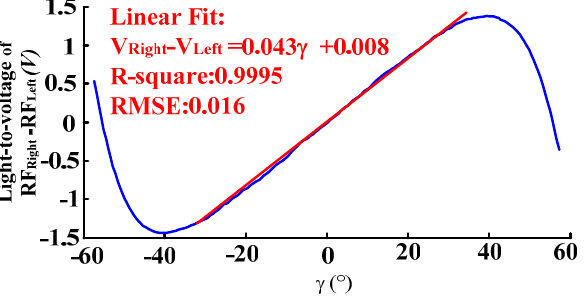
Figure 17. Angular displacement measurement experimental results. ( h = 500 μ m, p = 0 μ m, α = 20°).